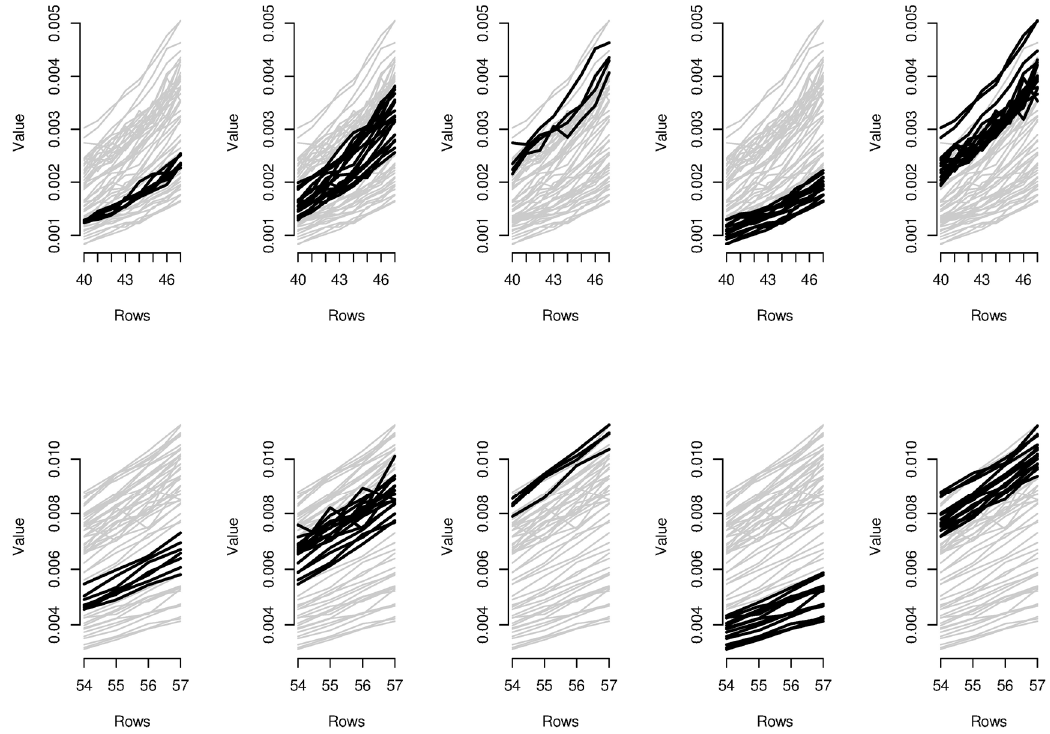
Figure 7. Parallel coordinate graphs for biclusters 11–20.